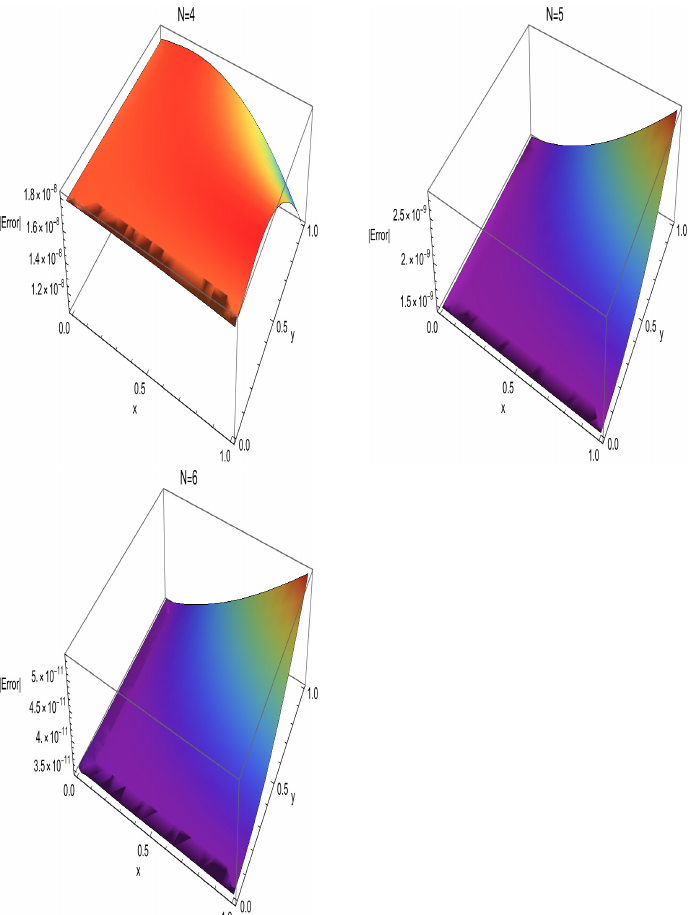
Figure 2. The absolute errors with ( u , v , ρ 1 , ρ 2 ) = ( 1/2,1/3,2,3 )